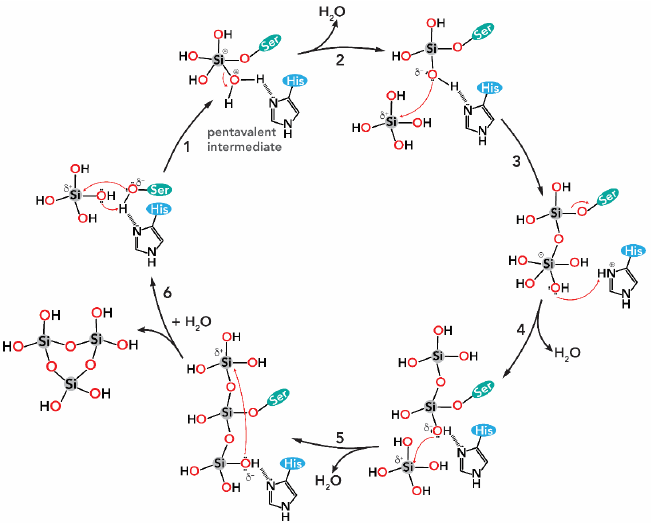
Figure 10. The proposed mechanism of silicatein-catalyzed polymerization of orthosilicic acid. Note that the example shown as product is a trisiloxane (SiO) 3 (OH) 6 . Adapted from [30] with permission from Springer Nature.